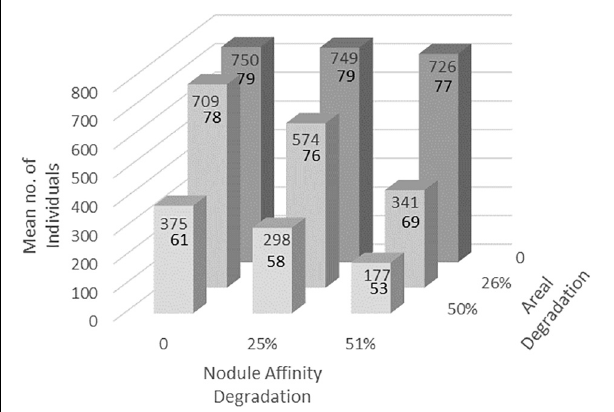
FIGURE 1 | Example of impacts of the degradation treatments on mean abundance (upper number) and mean morphospecies richness (lower number), for 2000 sub-samples calibrated to contain approximately 750 individuals initially (y-axis). For simplicity, just the “All” class is shown, i.e., without any data stratification. Note that the nodule affinity stressor alone (x-axis, back row of dark columns) has little or no impact, but that its influence becomes apparent when combined with the stochastic areal stressor (z-axis). These two different “StressorFactors” (in percent) and how they were applied, are described in section Materials and